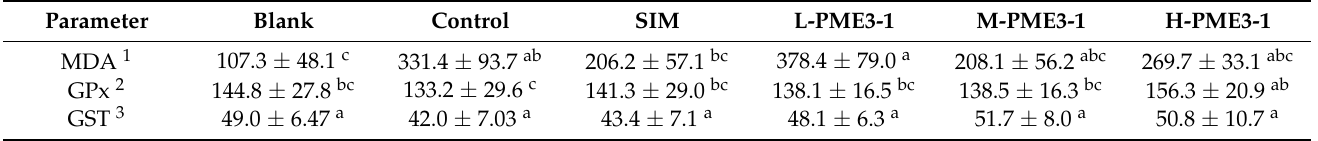
Table 6. Effects of PME3-1 on antioxidant activities of the liver tissue in high fat and cholesterol diet in hamsters.